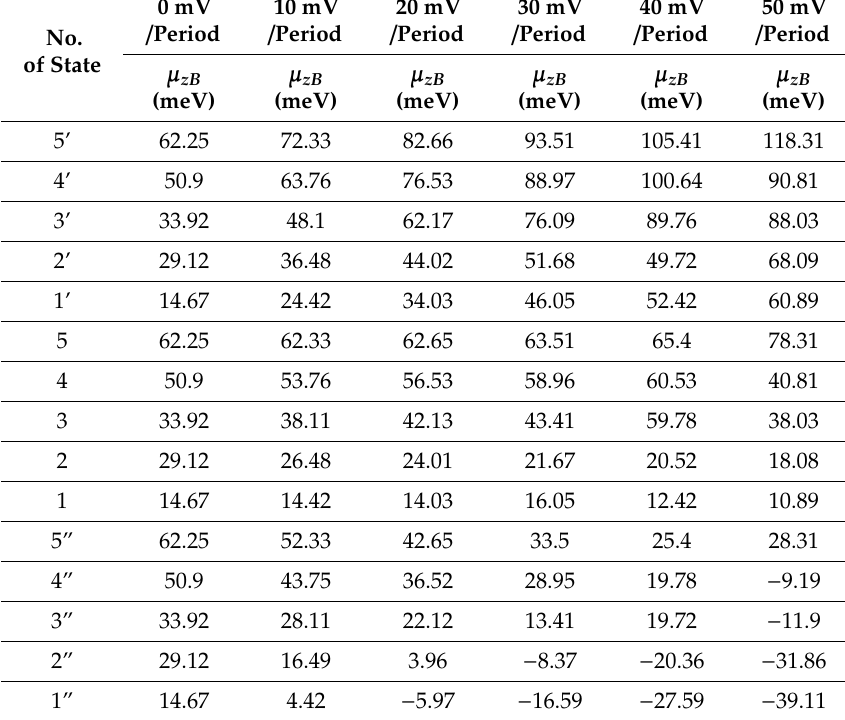
Table 2. Fermi levels for the Büttiker probes calculated for the structure no. 2, described in [24] at the assumed temperature T = 25